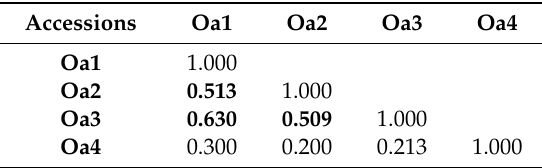
Table 4. Similarity coe ffi cients of the four habitats of Onopordum alexandrinum collected from four di ff erent habitats. 1 = Oa1 (sand dunes), 2 = Oa2 (abandoned fields), 3 = Oa3 (barley fields), 4 = Oa4 (desert plateau). Bold values indicate significant at p <